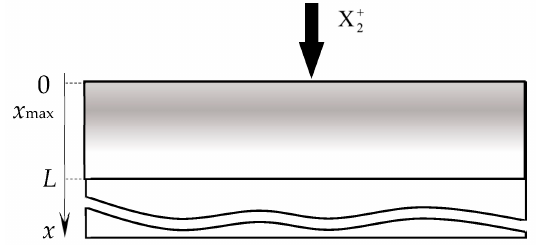
Figure 15. Distribution of implanted atoms in the target.